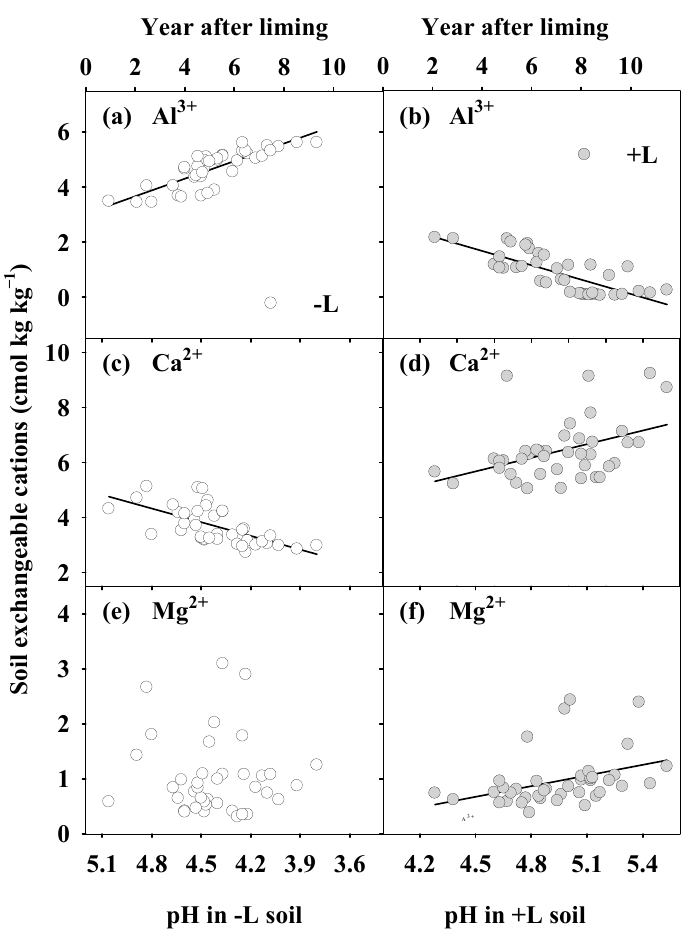
Figure 3. ( a ) Relationship between soil pH and soil exchangeable Al 3+ in − L (Al 3+ − L = − 2 × pH + 14.10, r 2 = 0.67); ( b ) in +L (Al 3+ +L = − 1.95 × pH + 10.54, r 2 = 0.57); ( c ) soil exchangeable Ca 2+ in − L (Ca 2+ − L = 1.66 × pH − 3.66, r 2 = 0.39); ( d ) in +L (Ca 2+ +L = 1.65 × pH − 1.74, r 2 = 0.16); ( e ) soil exchangeable Mg 2+ in − L (Mg 2+ − L = ns); and ( f ) in +L (Mg 2+ +L = 0.64 × pH − 2.23, r 2 = 0.11). The soil sampling depth was 0–20 cm with ns denoting p > 0.05. − L: without lime application, +L: with lime application.